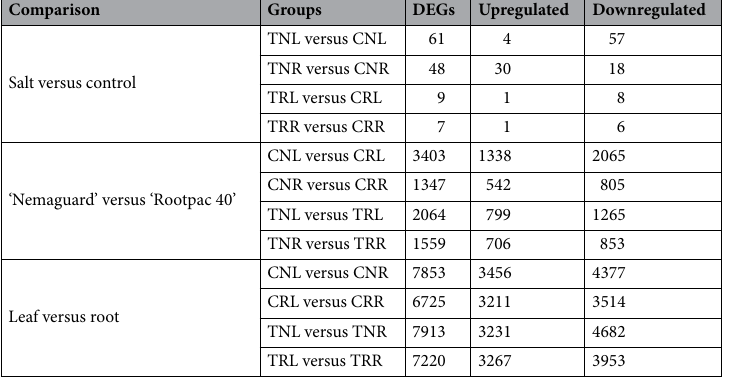
Table 1. Differentially Expressed Genes (DEGs) identified in different comparisons. CNL, control ‘Nemaguard’ leaf; TNL, treatment ‘Nemaguard’ leaf; CNR, control ‘Nemaguard’ root, TNR, treatment ‘Nemaguard’ root; CRL, control ‘Rootpac 40’ leaf, TRL, treatment ‘Rootpac 40’ leaf; CRR, control ‘Rootpac 40’ root; TRR, treatment ‘Rootpac 40’